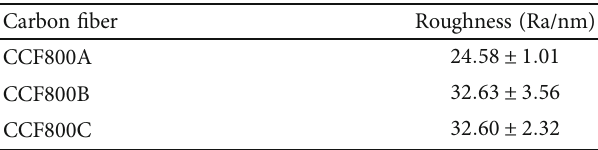
Table 3: The surface roughness of carbon fi ber. Carbon fi ber Roughness (Ra/nm)